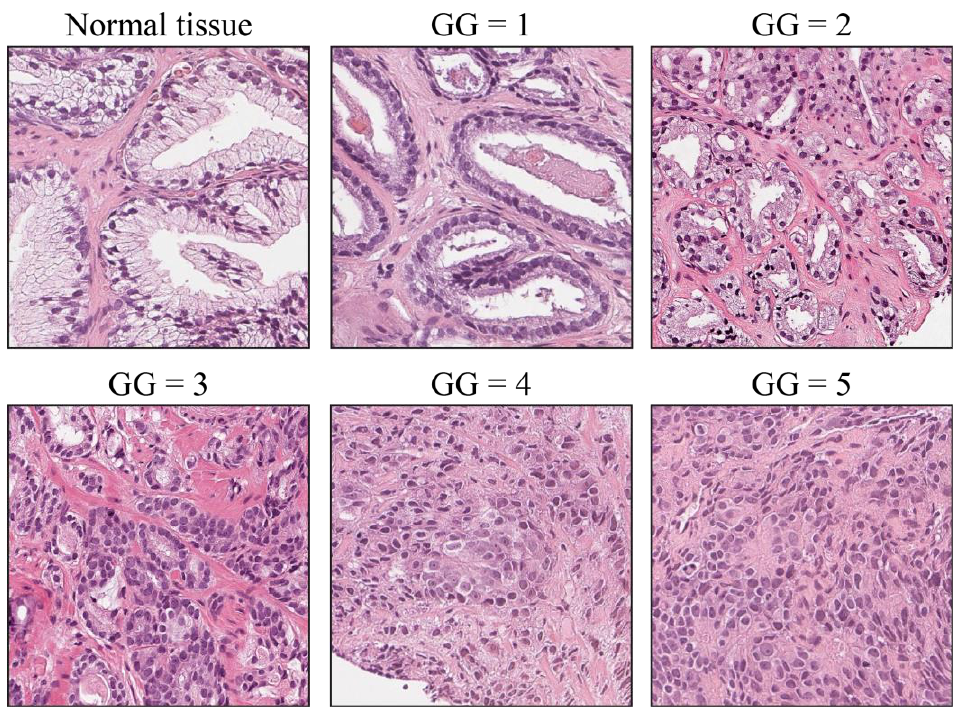
Figure 1. Prostate cancer grade groups. Normal prostatic tissue is shown for reference. Grade Group 1 (GG1) is a low-grade tumor with well-formed individual glands. With increasing GG, glands become fused, disorganized, solid, cribriform, or they are not formed at all (GG4, GG5).